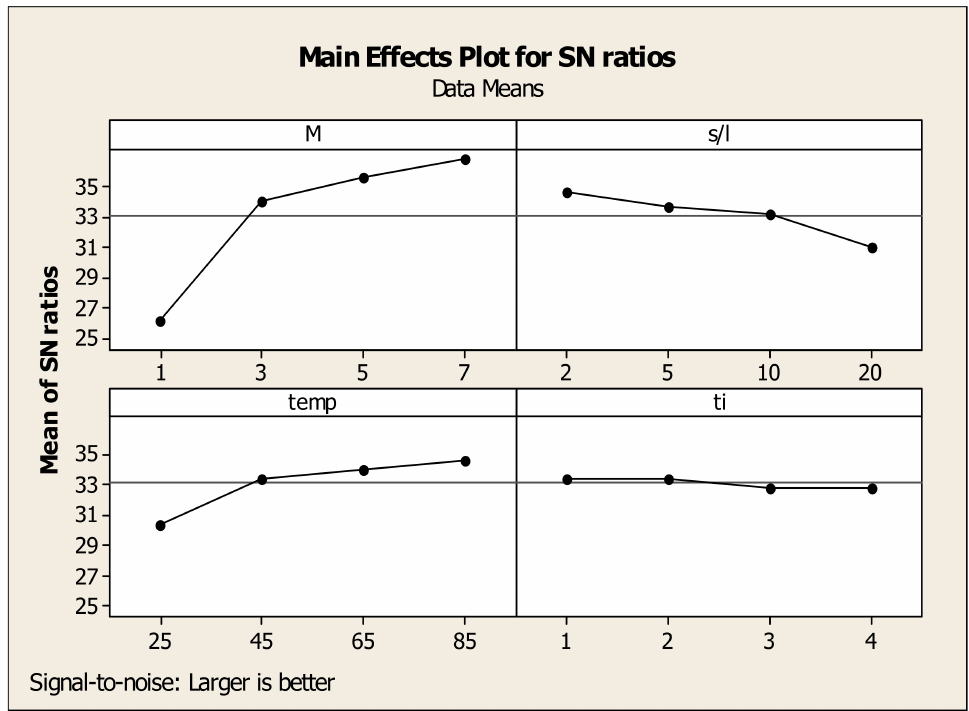
Figure 10. Effects of each factor associated with their levels on the statistical performance of S/N ratio for Sc recovery.